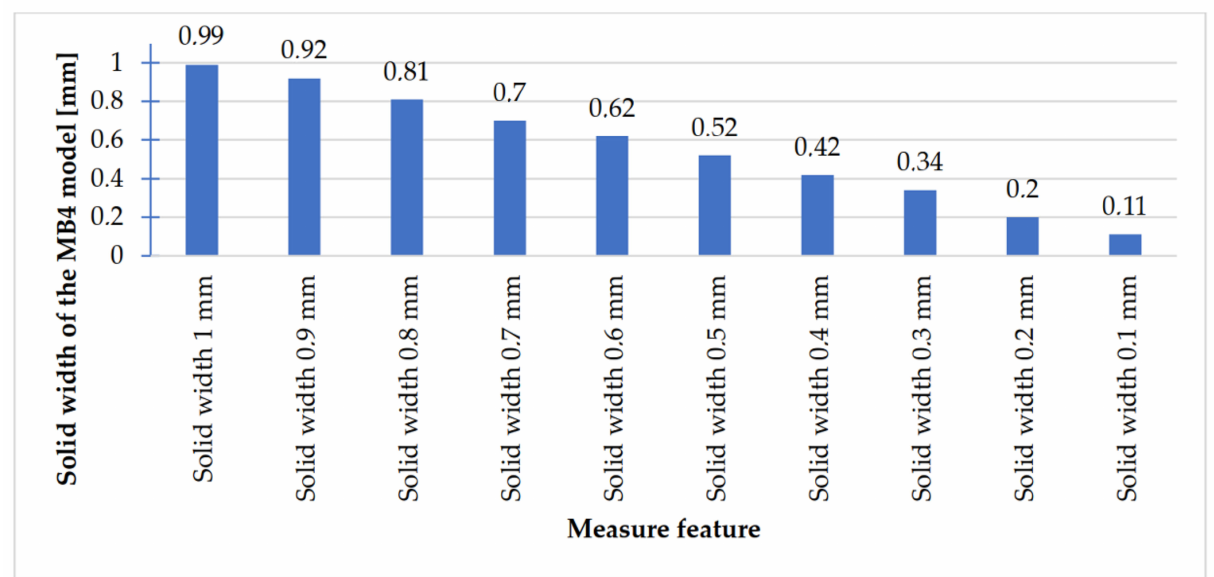
Figure 26. Measured values of rectangular solids with dimensions from 1 to 0.1 mm.